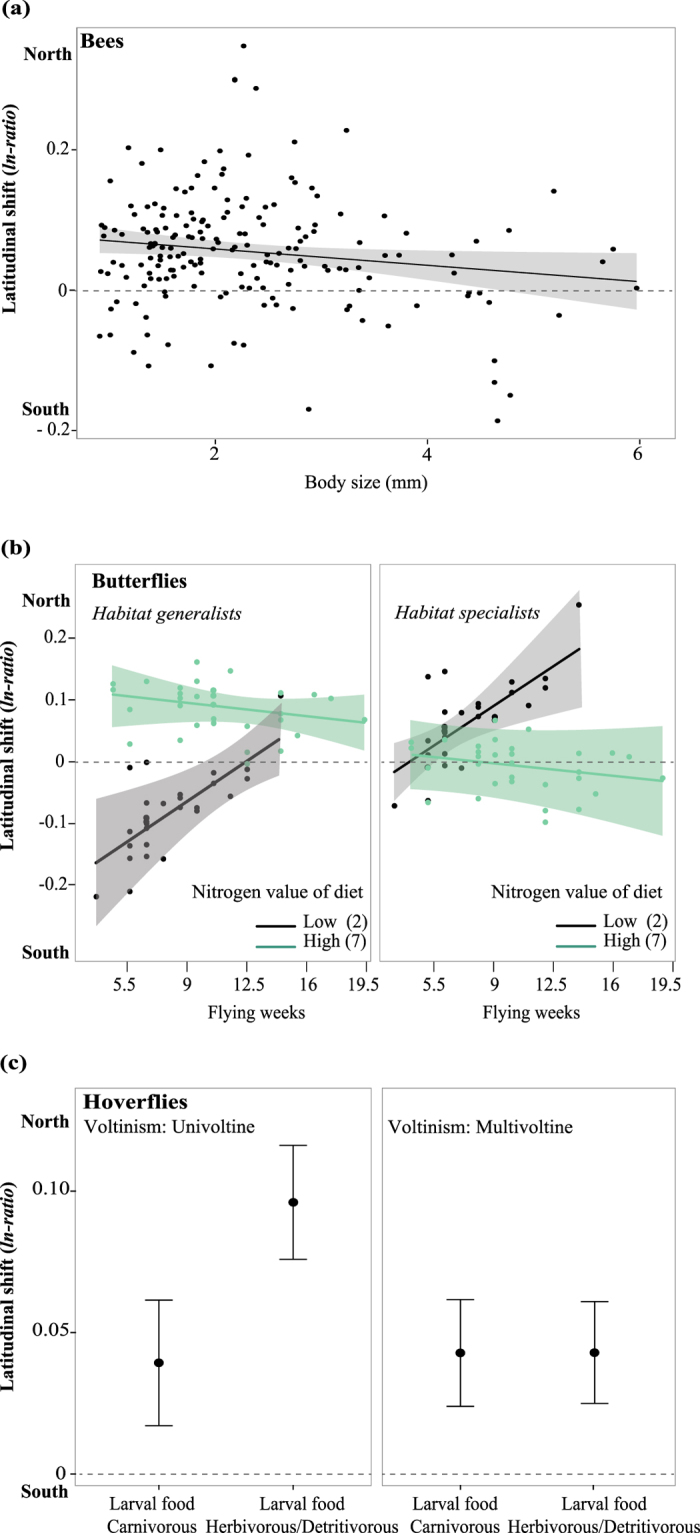
Latitudinal range shifts of pollinators (bees, butterflies, hoverflies) explained by species traits.(a) Effect of bee body size on latitudinal range shifts, with smaller species tending to shift more towards northern locations than larger species. (b) Butterfly latitudinal range shifts depend on habitat use (generalist vs. specialists), flight period length and larval host plant use. We present the model results for low (2) vs high (7) nitrophily values. Habitat generalists feeding on larval host plants with high nitrophily values (left panel: green dots) shift more towards the north than generalists feeding on plants with low nitrogen values (left panel: black dots). The opposite is observed for habitat specialists (right panel). Hence, butterfly species with larval host plants that have low nitrophily values (both panels: black dots) shift towards the south for generalists (left) but towards the north for specialists (right). Latitudinal range shifts of both specialists and generalists also depend on flight period, with northward shifts increasing with flying weeks when larval host plants have low nitrophily values, and decreasing when larval host plants have high nitrophily values. (c) Effect of voltinism and larval food plants on latitudinal shifts. Univoltine species (left panel) show smaller northward shifts in species which have larvae feeding on animals (carnivorous) compared to species with larval feeding on plants and organic matter (herbivorous/detritivorous. In contrast, there is no difference for multivoltine species (right panel). For all plots the average prediction ± 95% confidence intervals are shown. For statistical details see Supplementary Table S3.